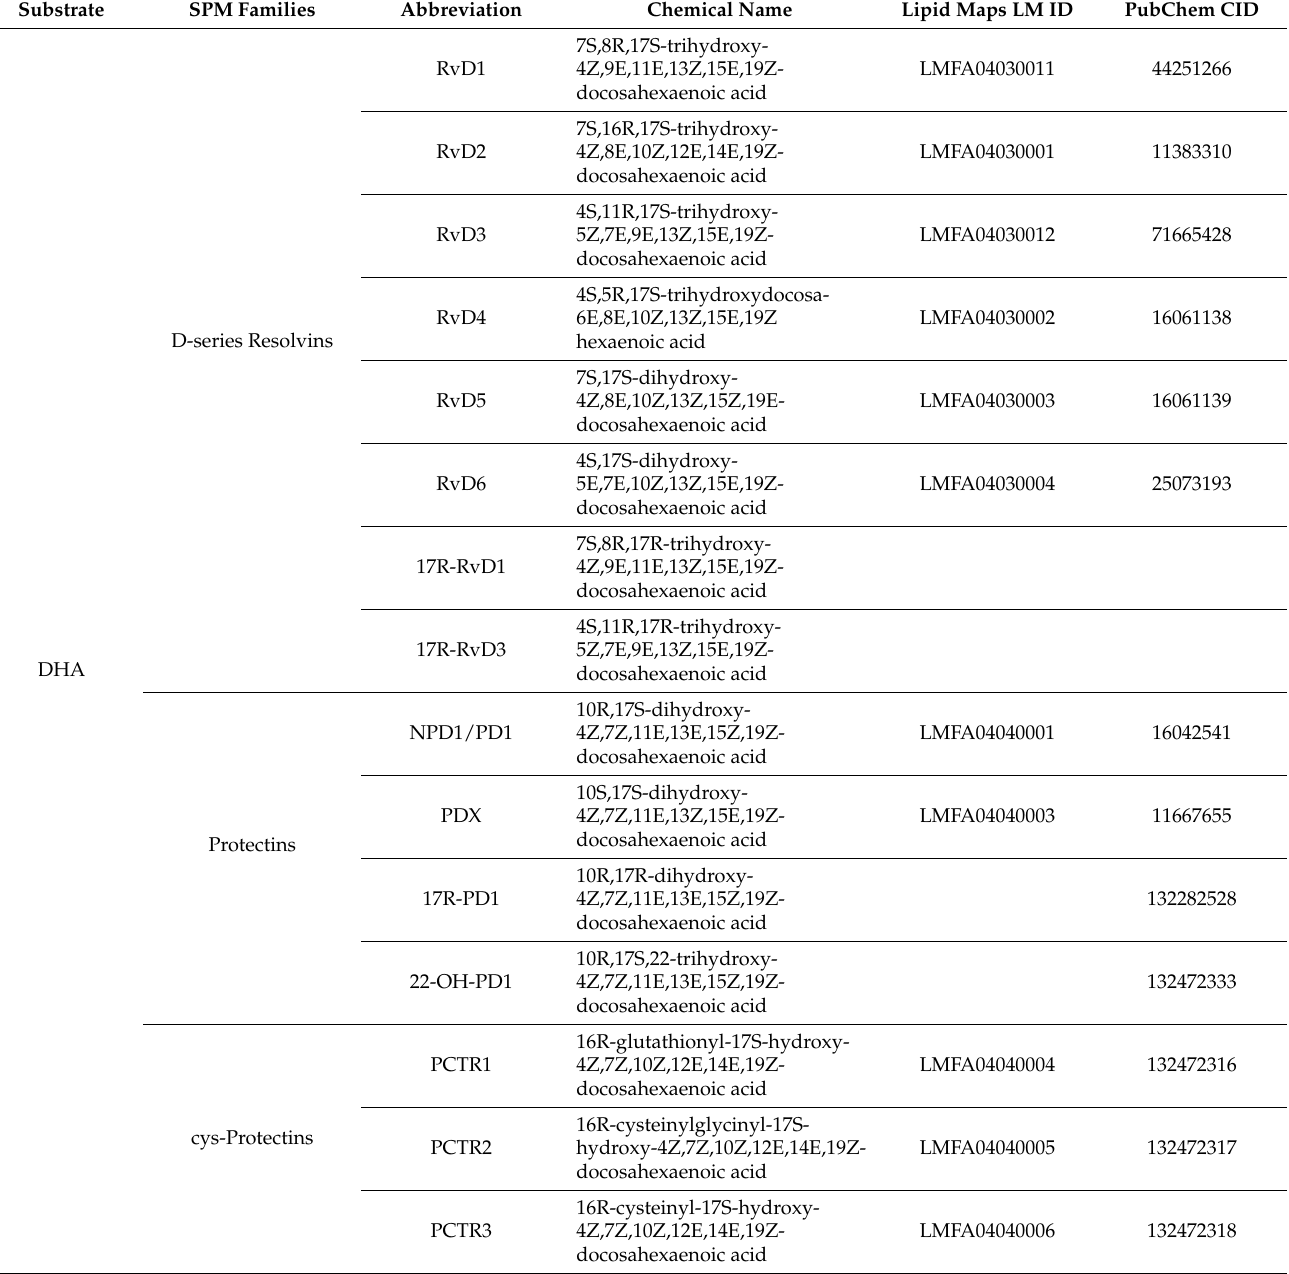
Table 1. Specialized pro-resolving mediator families and stereochemistries. This table provides a summary of the complete stereochemistries, where established, for the SPM distinct as subdivided by families and the essential fatty acid substrate from which they are derived. It also provides the public database reference numbers for each of these molecules where these are